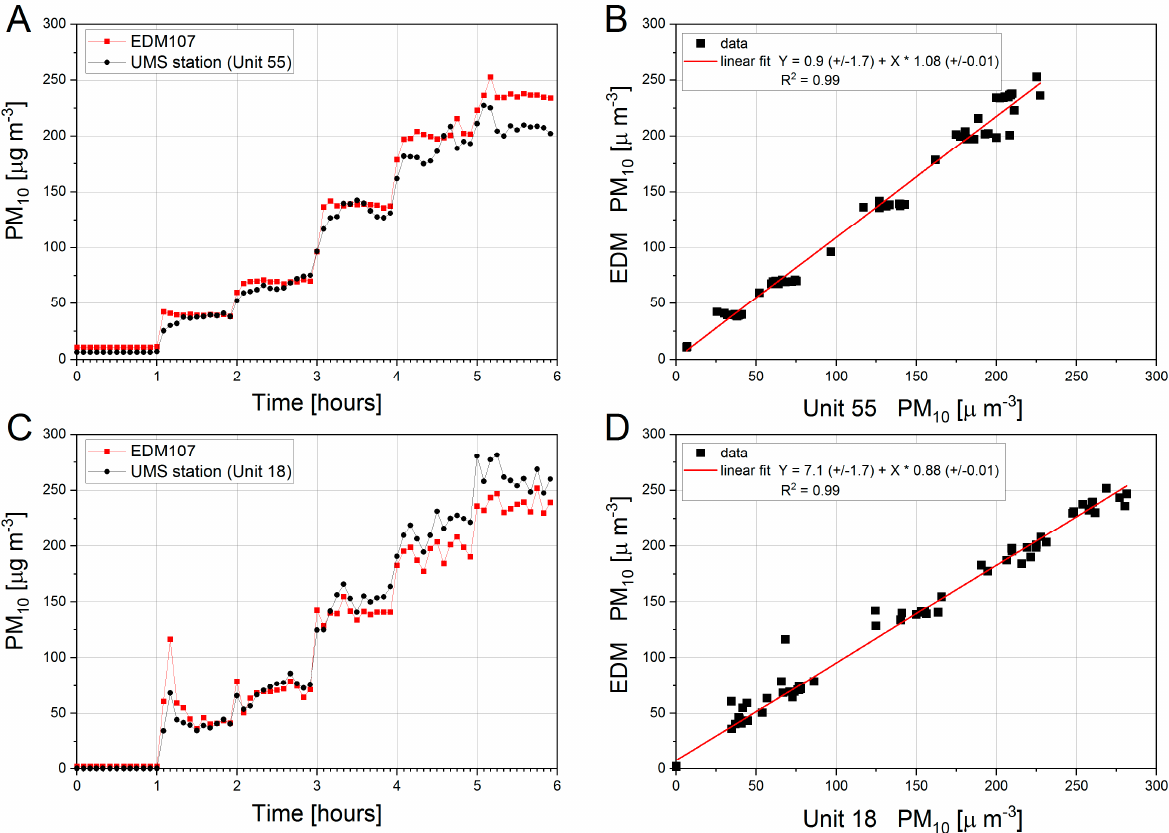
Figure 6. Panels ( A – D ). Results of the PM 10 calibration of two UMS stations (Unit 55, Unit 18) in concentration range from 40 to 240 µg·m − 3 . Panels A and C present PM 10 values recorded as a function of time by EDM 107 are marked in red and those recorded by UMS stations—in black. Panels B and D present the relation of PM 10 concentrations obtained from UMS (Unit 55 and Unit 18, respectively) and reference station EDM107. The linear fit was drawn as red line. The data presented in this figures are the mean values of 5 min long measurements.